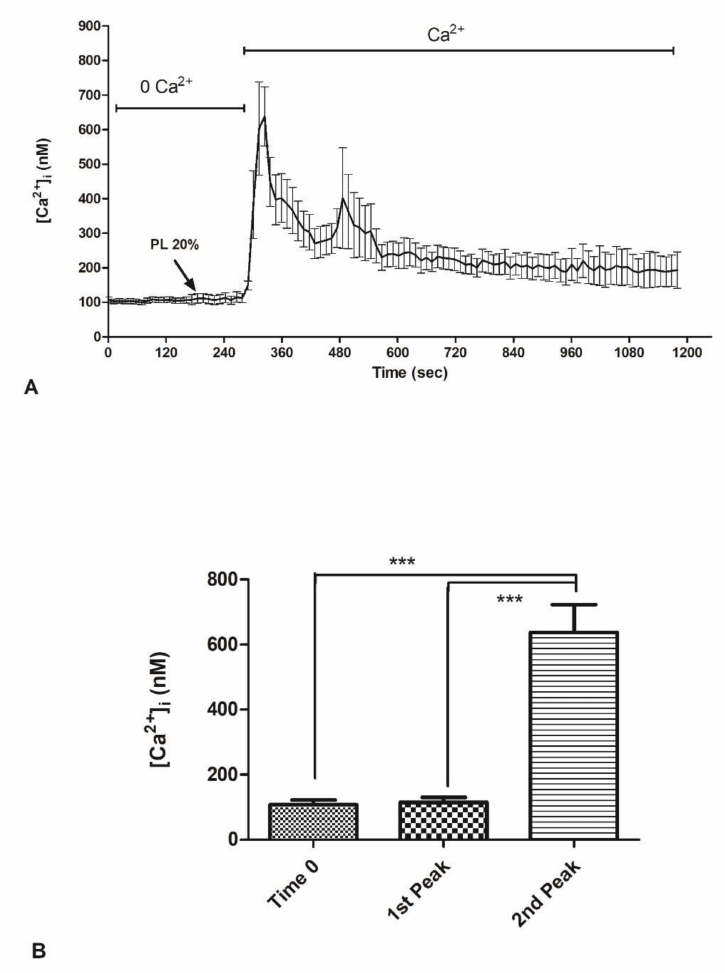
Figure 3. PL-induced Ca 2 + entry from the extracellular space in bEND5 cells. ( A ) To monitor exclusively intracellular Ca 2 + mobilization, bEND5 cells were stimulated with 20% PL in the absence of external Ca 2 + (0Ca 2 + ). When Ca 2 + has been added back to the medium, there was [Ca 2 + ] i increase. ( B ) Mean ± s.e.m. of the Ca 2 + response at time zero and to 20% PL recorded after PL addition (first peak) and at the peak after Ca 2 + supplement in extracellular space (second peak). Data are means ± s.e.m. of [Ca 2 + ] i measured by confocal imaging of 40 cells from 3 experiments Di ff erent asterisks on bars indicate statistical di ff erences by one-way ANOVA according to Tukey’s test ( p <